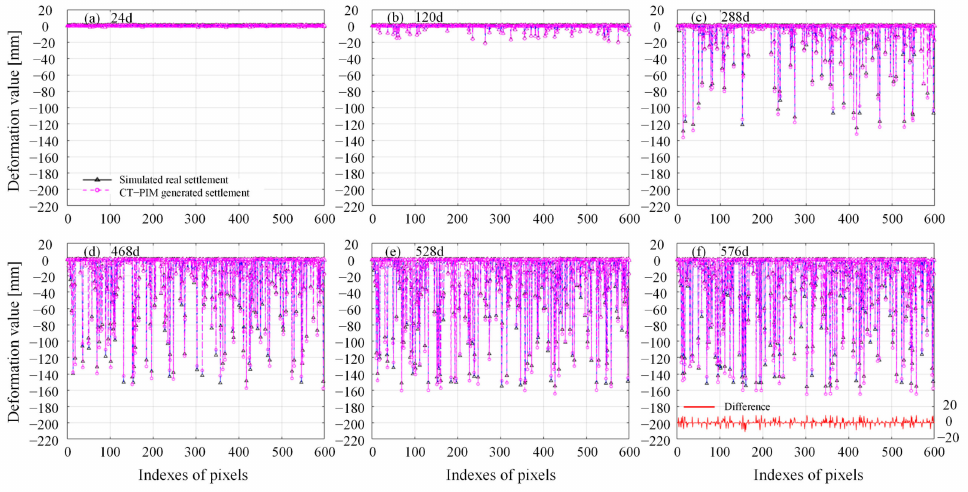
Figure 5. Comparison between the CT-PIM generated deformation sequences (six periods are selected) and the simulated real